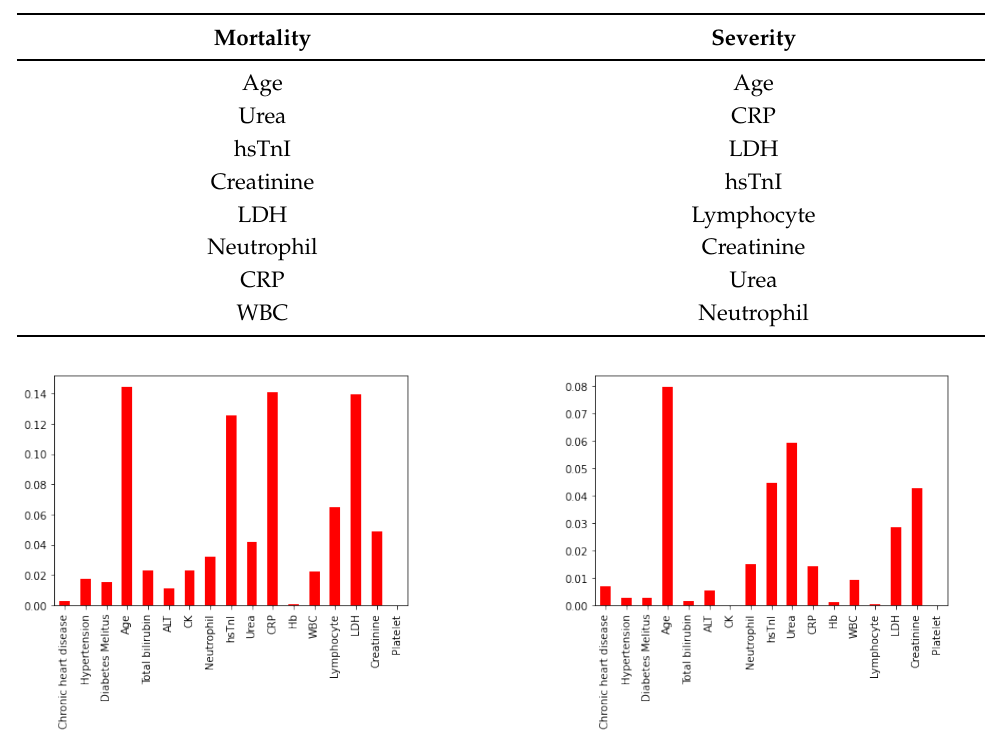
Table 10. The 8 features most associated with the two outcomes, as predicted by the mutual informa- tion classifier.